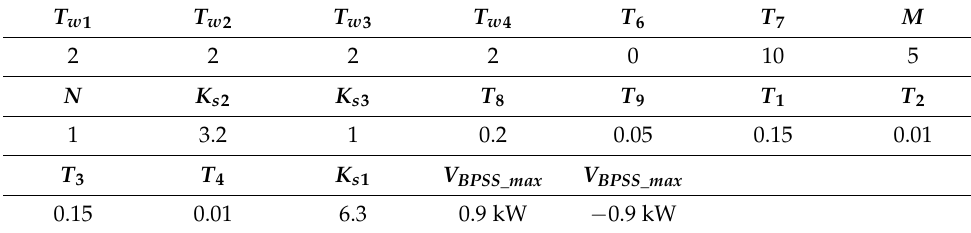
Table 4. Parameters of built-in PSS of inverter for experiment.